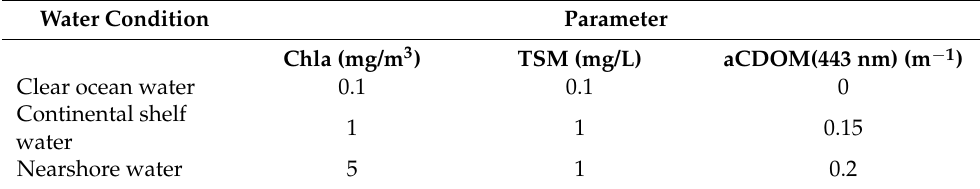
Table 2. Parameter settings for three different water types [19]. Water